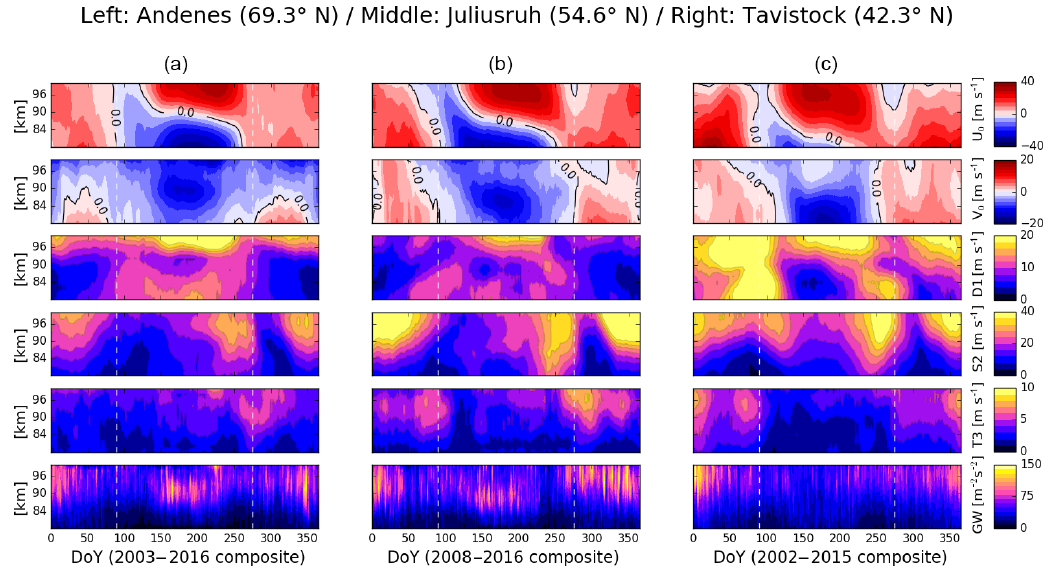
Figure 1. Composites of mean zonal ( U 0 ) and meridional winds ( V 0 ), diurnal, semidiurnal and terdiurnal solar tides (D1, S2 and T3, respectively), and GW kinetic energy over (column a ) Andenes, (column b ) Juliusruh and (column c ) Tavistock. The vertical white dashed lines indicate DoYs 90 and 275. The composites were determined for the entire yearly datasets available at the time this study was